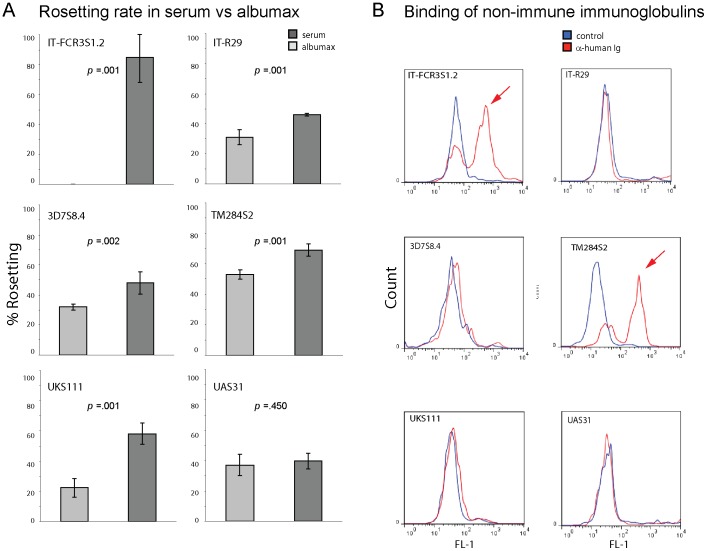
Rosette formation and binding of non-immune immunoglobulins in laboratory stains and patient isolates.A: Different parasite strains and patient isolates were grown in medium complemented with human serum or albumax. The rosetting rate at 34–38 h p.i. was assessed in three consecutive cycles in the different conditions (dark grey: presence of human serum, light grey: absence of human serum). Graph shows mean of three experiments with range. B: Binding of non-immune immunoglobulins in the corresponding parasite lines to the surface of the pRBC surface as visualized with an anti-human Ig antibody (red: anti-human Ig-Alexa, blue: control antibody), immunoglobulin binding pRBCs are marked with red arrows.